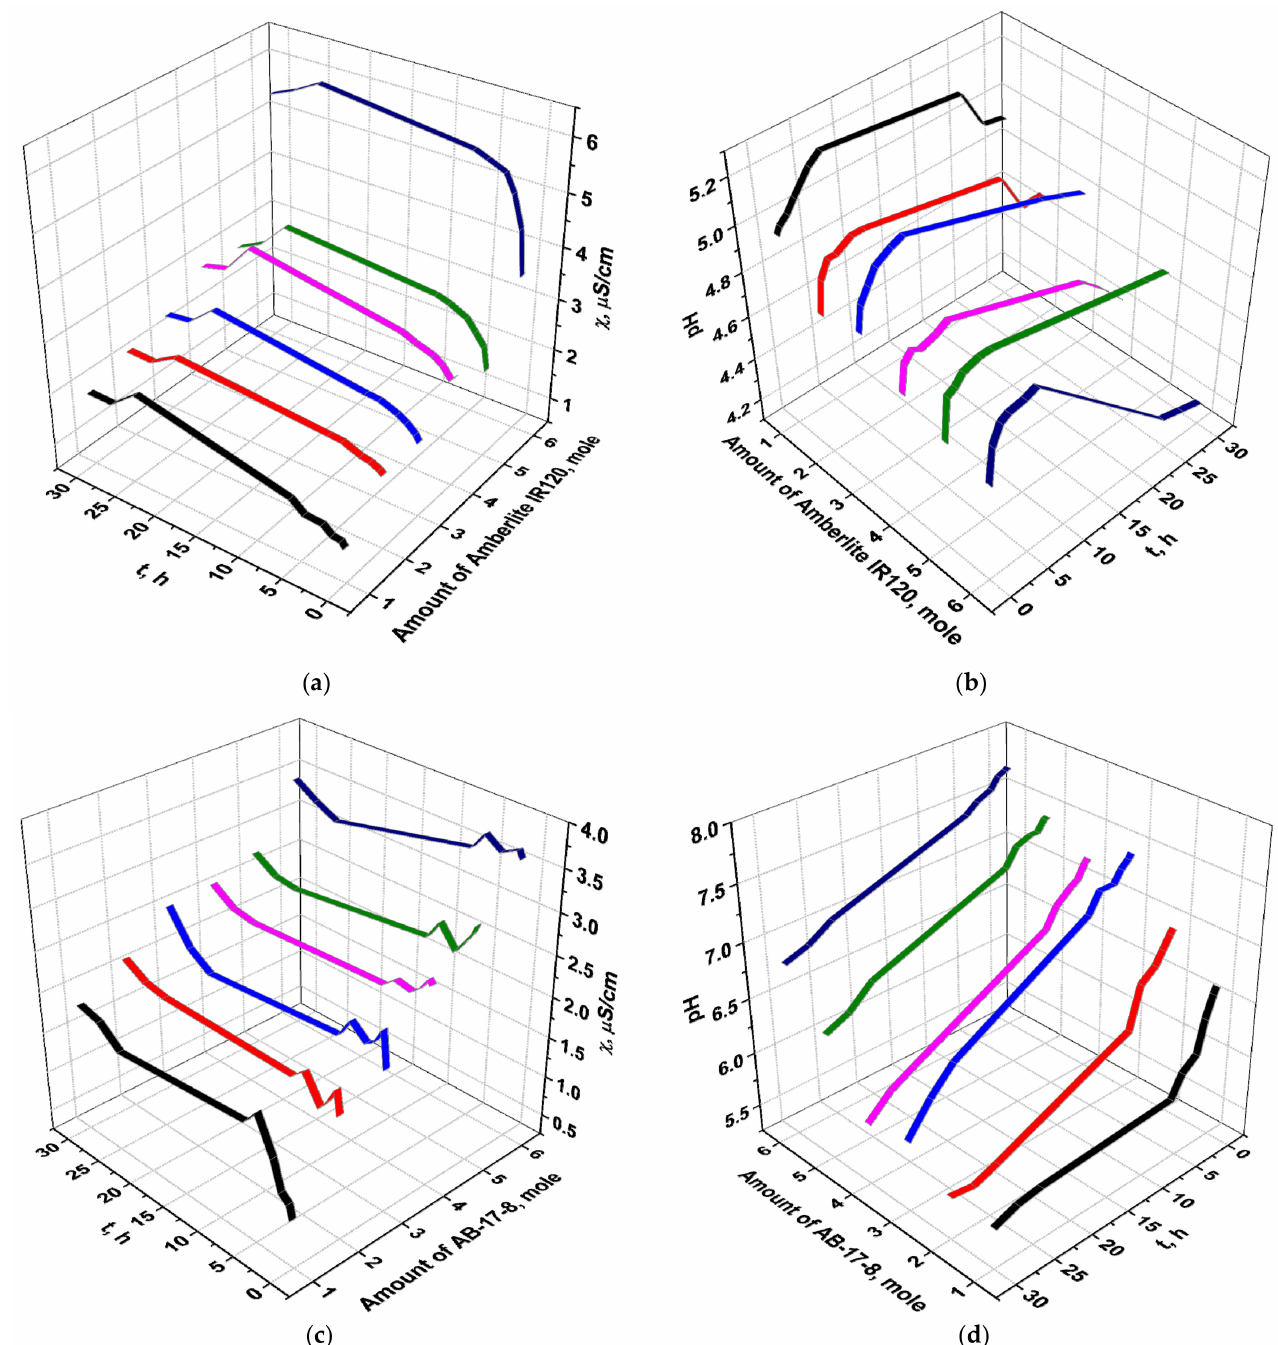
Figure 1. Specific electric conductivity and pH of aqueous medium in the presence of individual structures: Amberlite IR120 ( a , b ) and AB-17-8 ( c , d